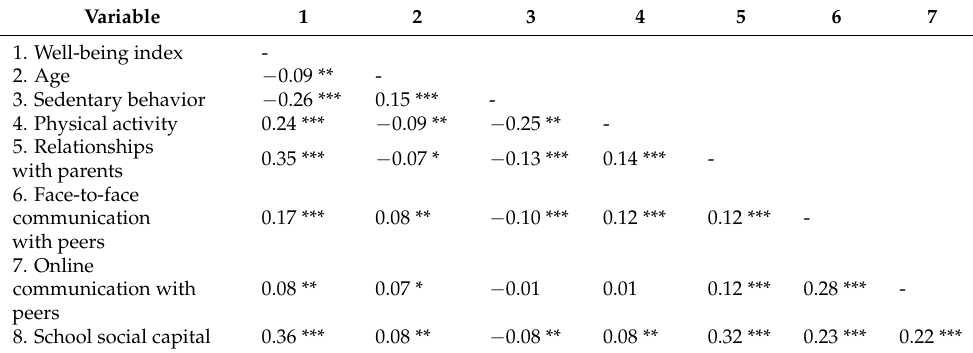
Table 2. Bivariate correlations among study variables.